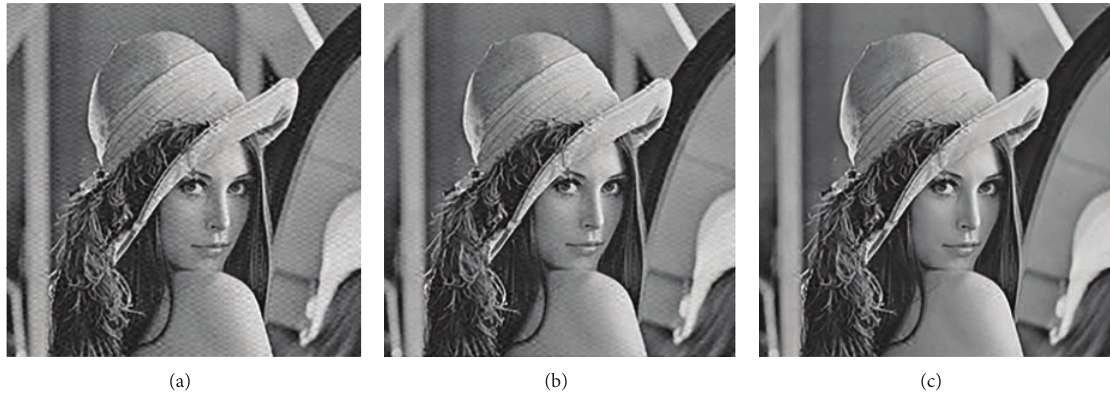
Figure 7: Illustration of the images watermarked by the PostHIW with Rbst QF set to be 70, 80, and 90, respectively. (a) Lena (Rbst QF = 70 , = 20.88). (b) Lena (Rbst QF = 80 , PSNR = 36.09 dB, 𝐷 Post PSNR = 33.35 dB, 𝐷 Post DWT = 15.32).